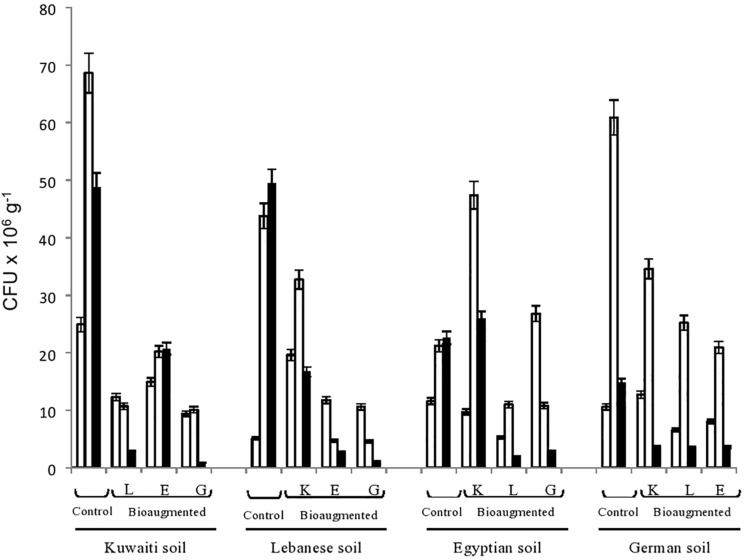
Numbers of hydrocarbonoclastic bacteria in the four remote, oily soil samples during their bioremediation via cross-bioaugmentation. Open columns, time zero; dotted columns, 3 months; closed columns, 6 months of bioaugmentation. L, Lebanese; E, Egyptian; K, Kuwaiti; G, German soils for cross-bioaugmentation.